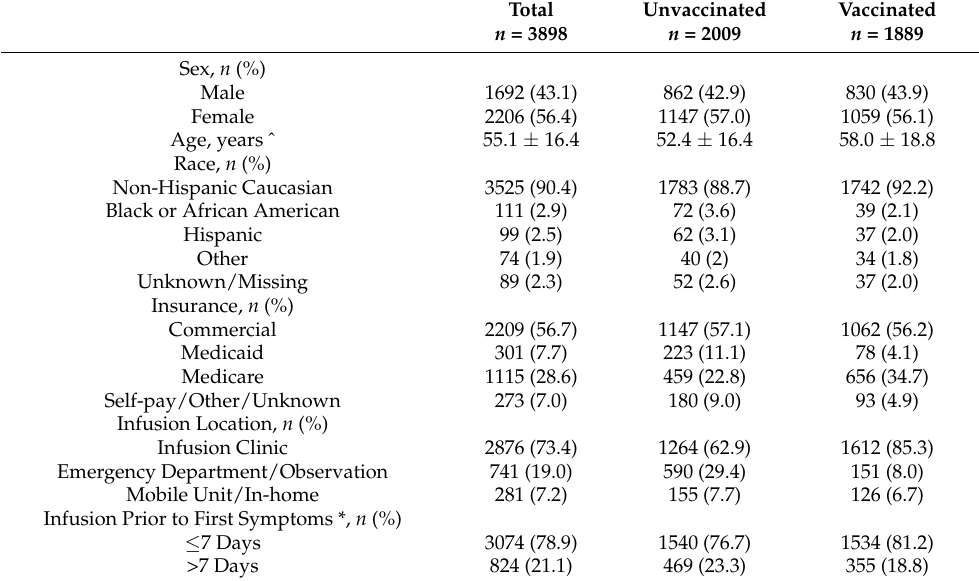
Table 1. Patient Characteristics.